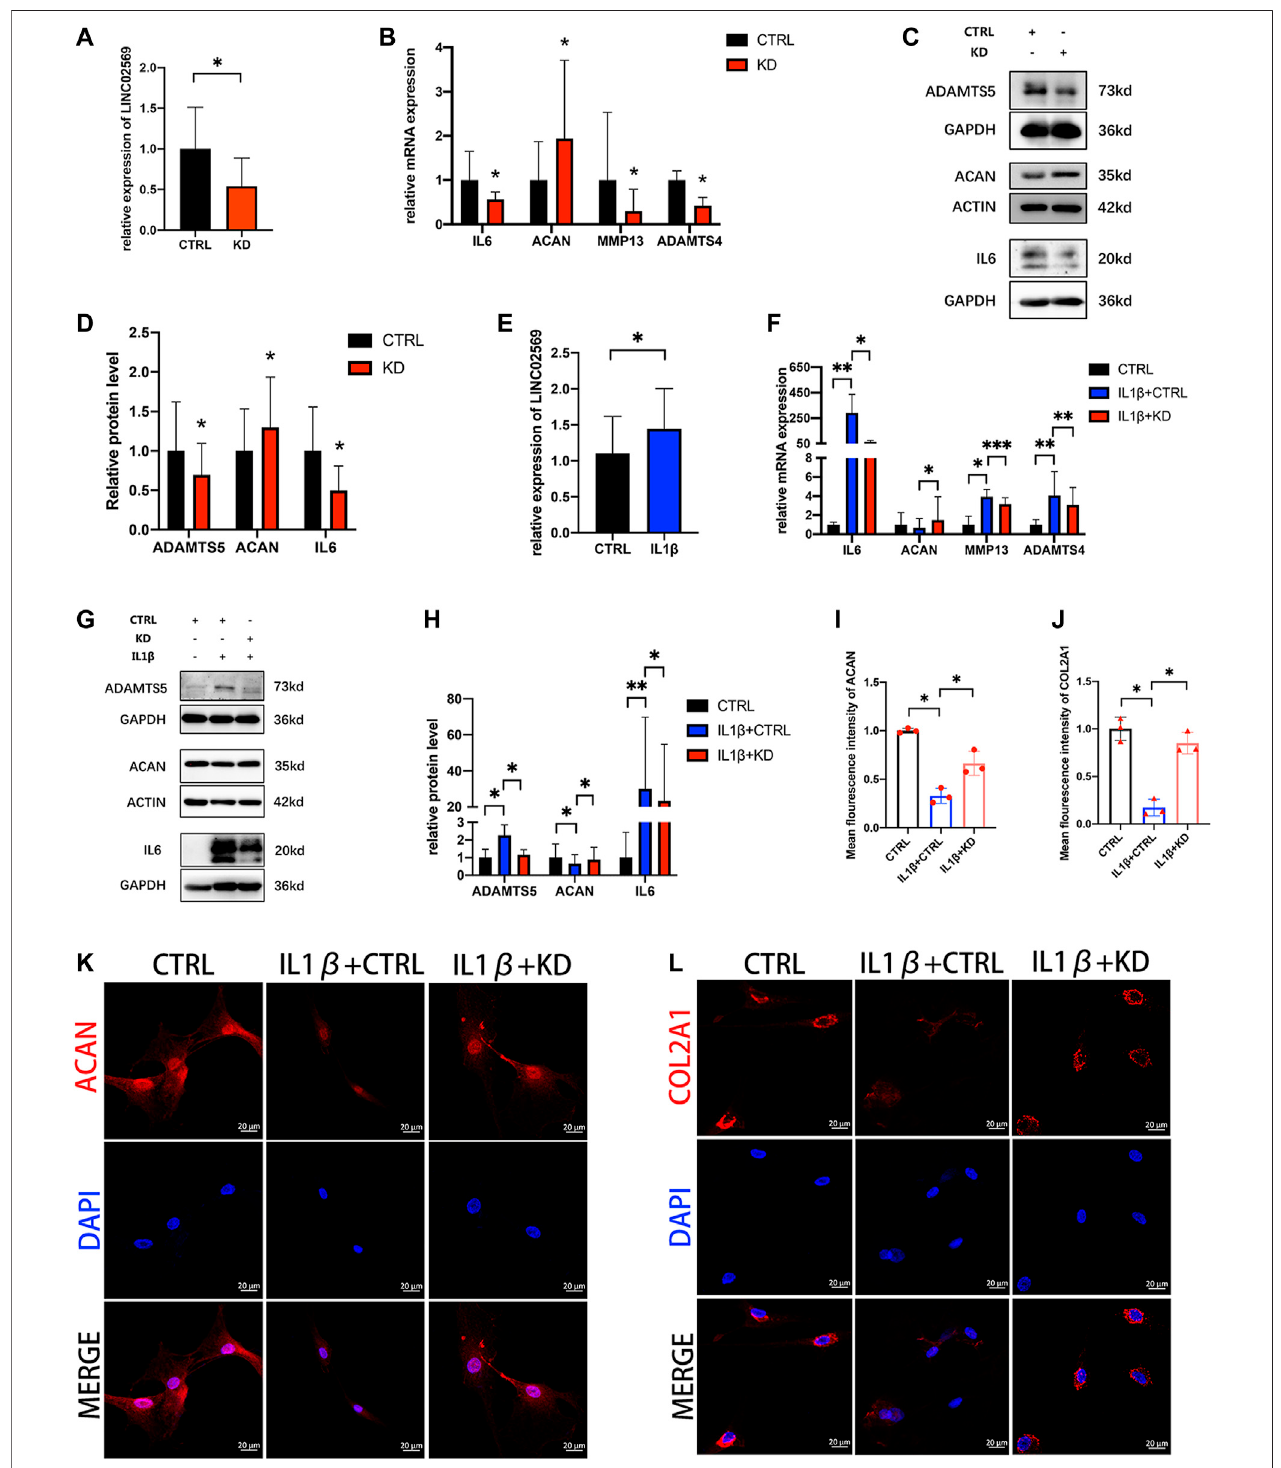
FIGURE4| KnockdownofLINC02569attenuatedNPCsdegeneration. (A) qRT-PCRassayofLINC02569expressioninLINC02569knockdownNPCs. (B) qPCR assay of IL6, ACAN, MMP13, ADAMTS4 expression in LINC02569 knockdown NPCs. (C,D) Protein levels of IL6, ACAN and ADAMTS5 determined by WB analyses of lysates from LINC02569 knockdown NPCs. (E) qRT-PCR assay of LINC02569 expression in NPCs treated with IL-1 β for 24 h. (F) qRT-PCR assay of IL6, ACAN, MMP13 and ADAMTS4 expression in LINC02569 knockdown NPCs treated with IL-1 β . (G,H) Protein levels of IL6, ACAN and ADAMTS5 determined by WB analyses of lysates from LINC02569 knockdown NPCs treated with IL-1 β . (K, L) Representative confocal images of ACAN (K) and COL2A1 (L) formation. Scale bar: 20 μ m. (I) Quantitation of panel (K) . (J) Quantitation of panel (L) . Quantitative results are from 3 independent experiments and are shown as the mean ± SD. p p < 0.05, pp p < 0.01, *** p < 0.001.